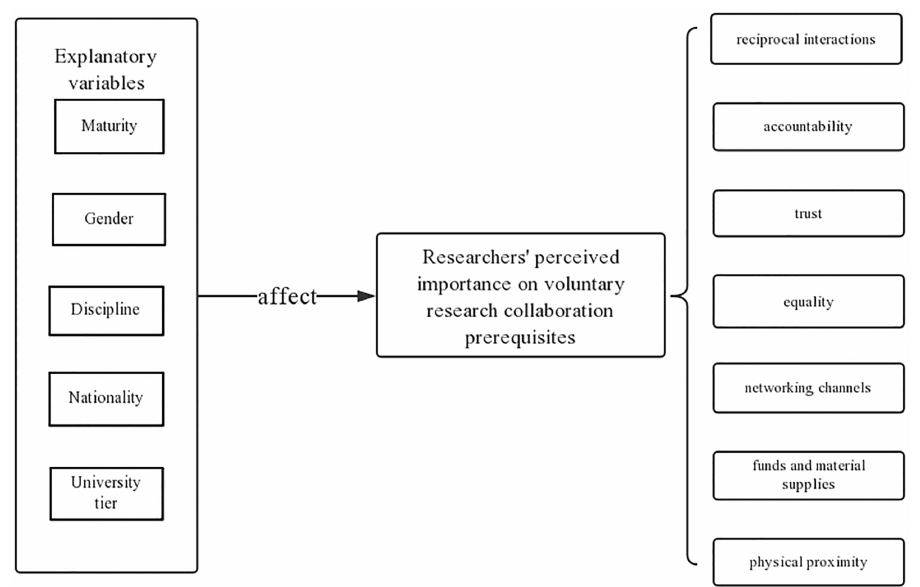
Fig 1. Assumption that different nationalities, disciplinary domains, maturity levels and university rankings could affect researchers’ perceptions of the prerequisites for research collaborations.